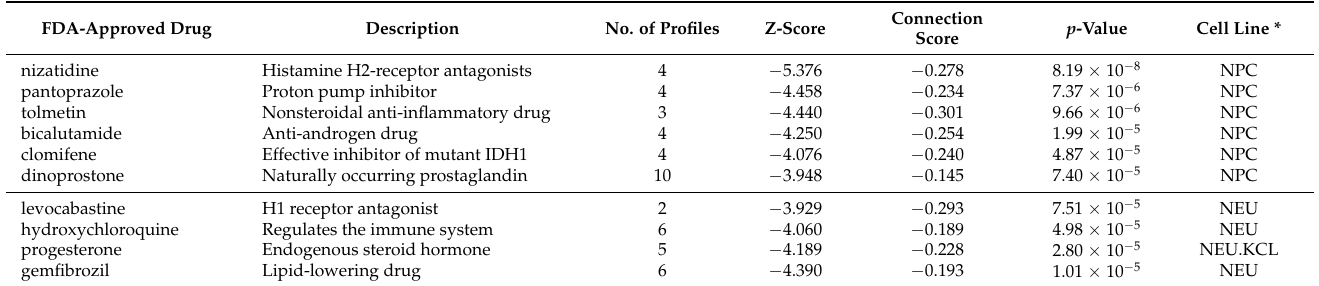
Table 2. Significant negative connections to target compounds for neuronal cell lines identified by QUADrATiC software that could potentially reverse the recGBM